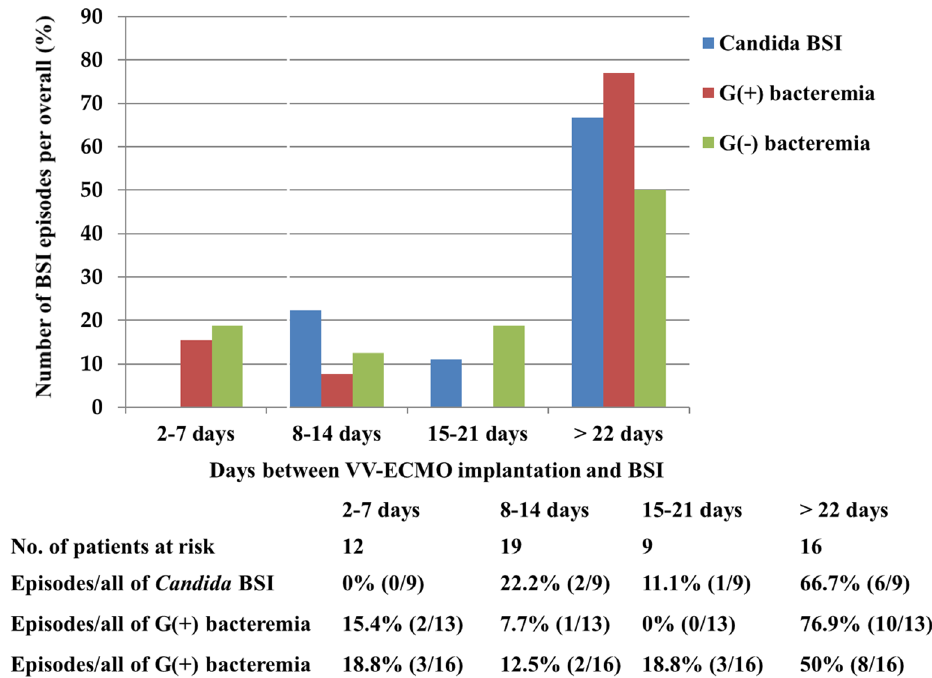
Figure 2. Number of each type of BSI episodes to the overall number of BSI episodes (%) among VV ECMO patients that was stratified by days between ECMO implantation and